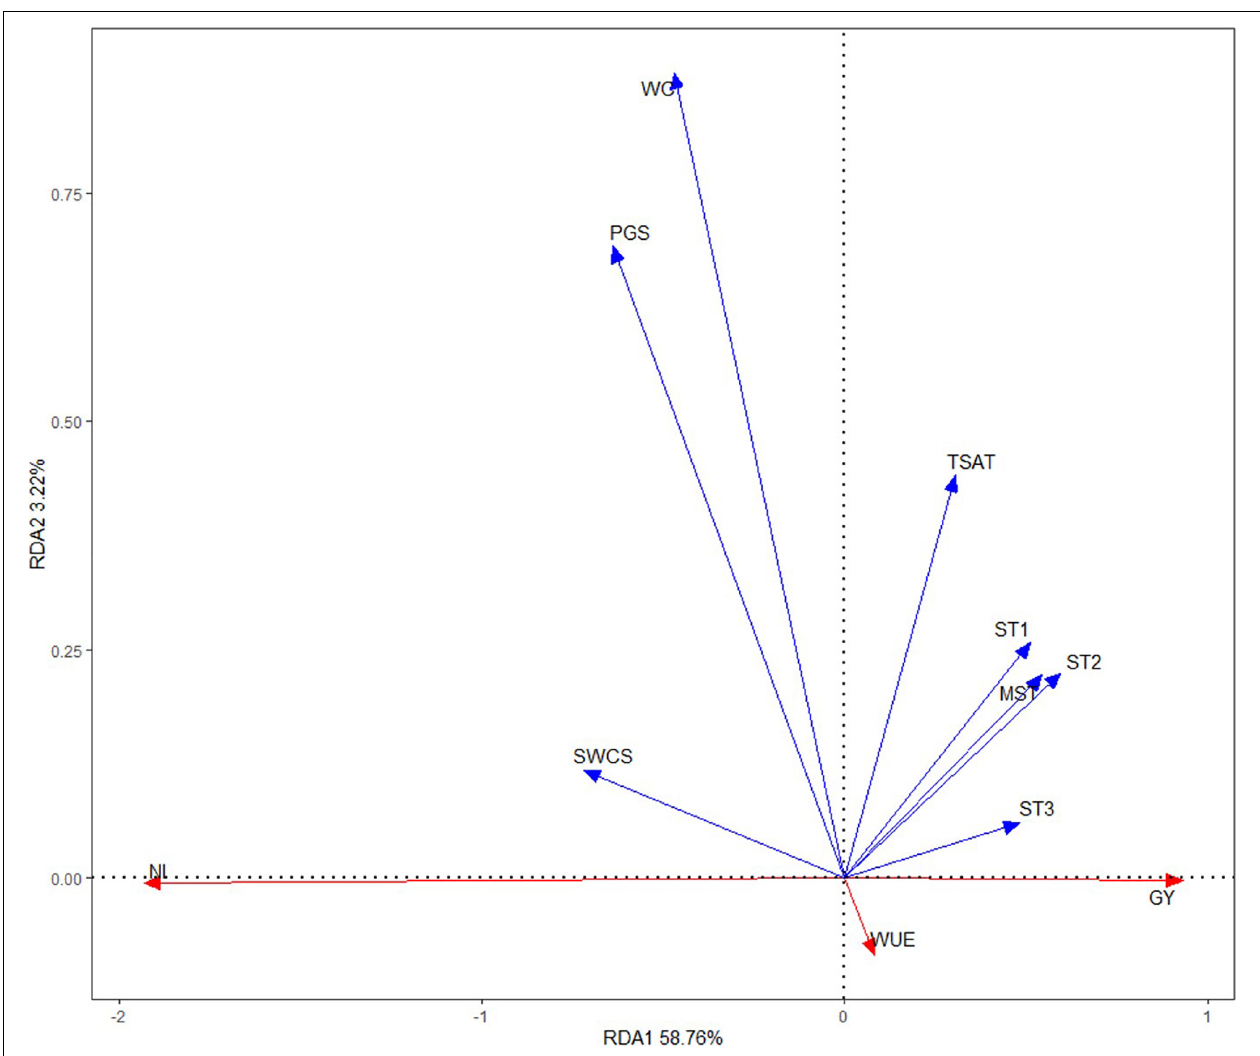
FIGURE 8 | Redundancy analysis (RDA) based on the grain yield (GY), water use efficiency (WUE), net income (NI), and climate and soil hydrothermal factors at the Wuwei Experimental Station in northwestern China. SWCS, soil water content at sowing; WC, water consumption; ST1, soil temperature from seedling to jointing; ST2, soil temperature from big flare to early filling; ST3, soil temperature from early filling to full ripe; MST, mean soil temperature; TSAT, total soil accumulated temperature; PGS, precipitation across the maize growth season; AT, air temperature.